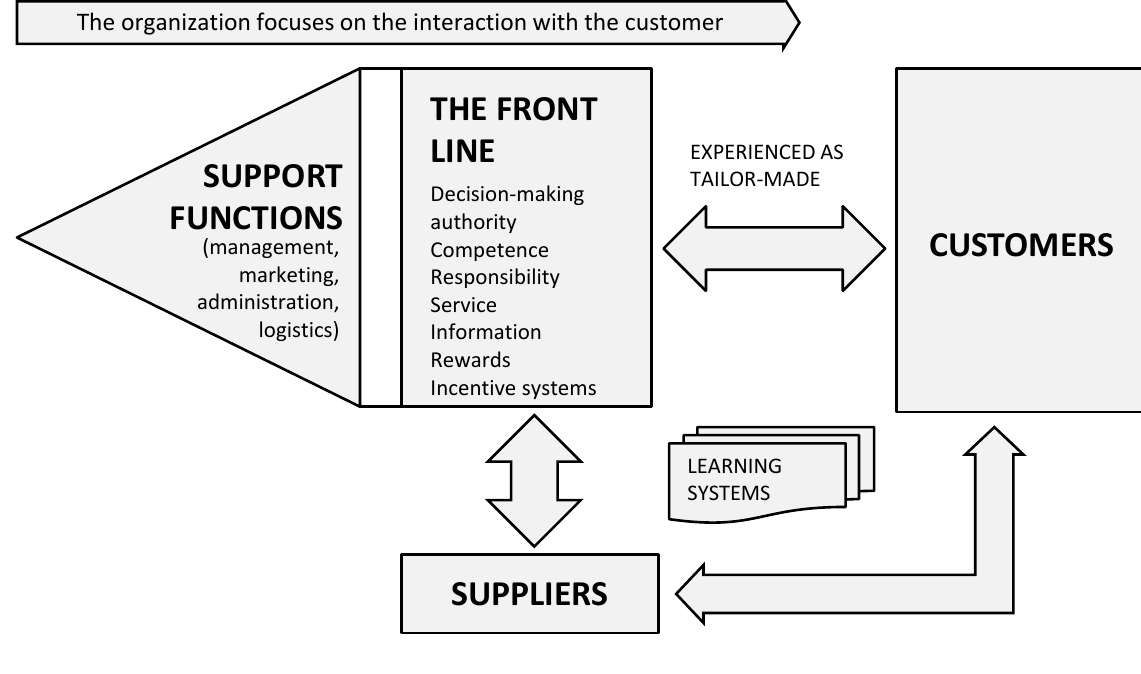
Figure 3. Frontline